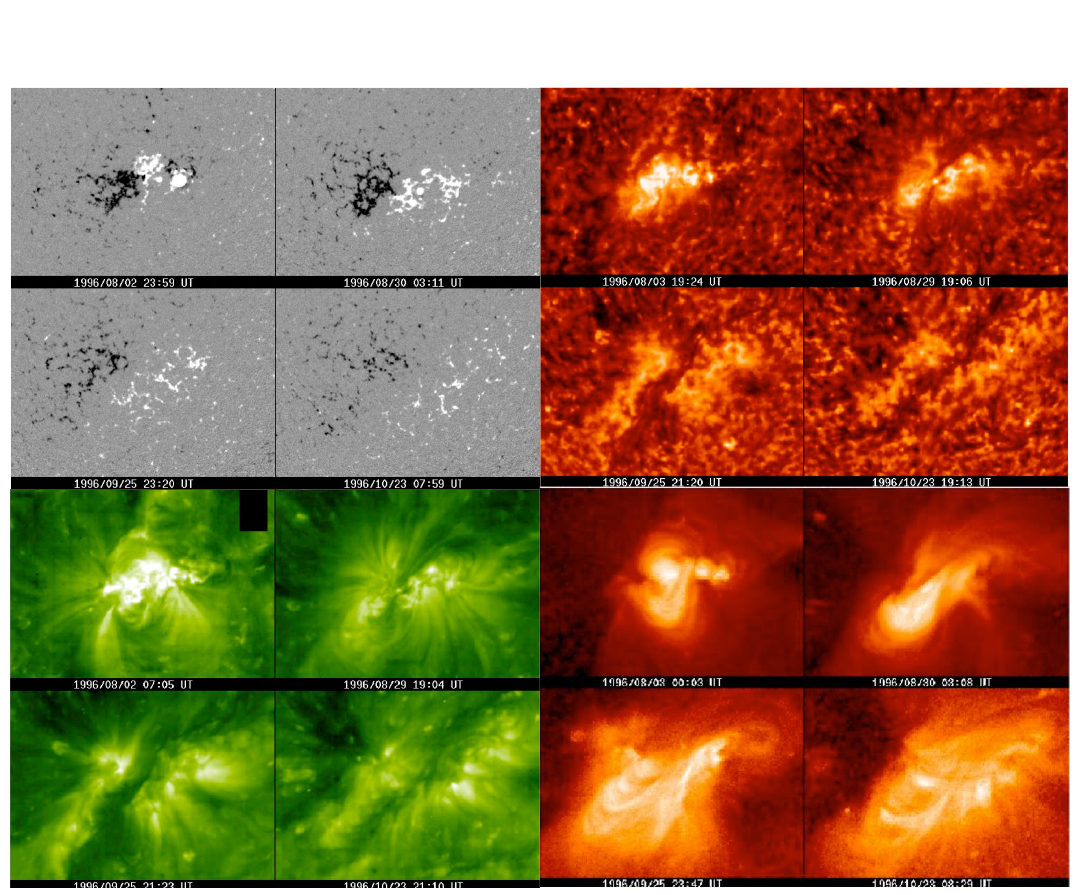
Figure 30: Multiwavelength images of AR 7978 during four rotations (2nd – 5th) showing the evolution of magnetic fields (SOHO/MDI data, upper left), 304 ˚A He ii (SOHO/EIT, upper right), 171 ˚A Fe ix (SOHO/EIT, lower left), and SXRs ( Yohkoh /SXT, lower right). Note that the spatial distribution of the emission in hotter lines (1 – 2 MK) is similar to that in 304 ˚A, but as the magnetic field was getting dispersed, and the loops grew, there was a re-organisation of the emission with height. At earlier times hot and dense plasma fully filled the loops, while later the EUV loops were only partially filled, as they became taller than the gravitational scale height. In SXRs ( 𝑇 ≈ 2 – 5 MK) more fully filled loops were observed besides an increasing presence of a diffuse